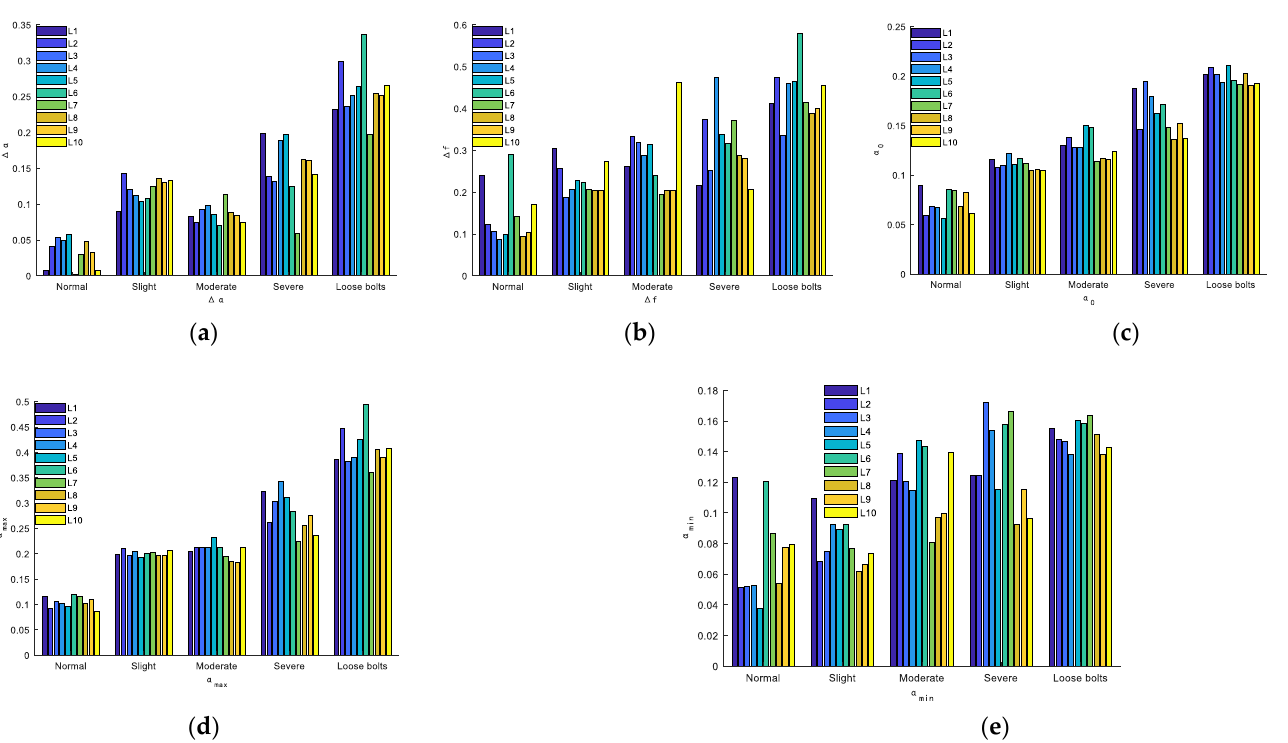
Figure 7. Stability of the characteristic parameters of the centrifugal pump vibration signals: ( a ) ∆ α , ( b ) ∆ f , ( c ) α 0 , ( d ) α max , ( e ) α min Table 3. Statistical data of the characteristic parameters of the centrifugal pump vibration signals.